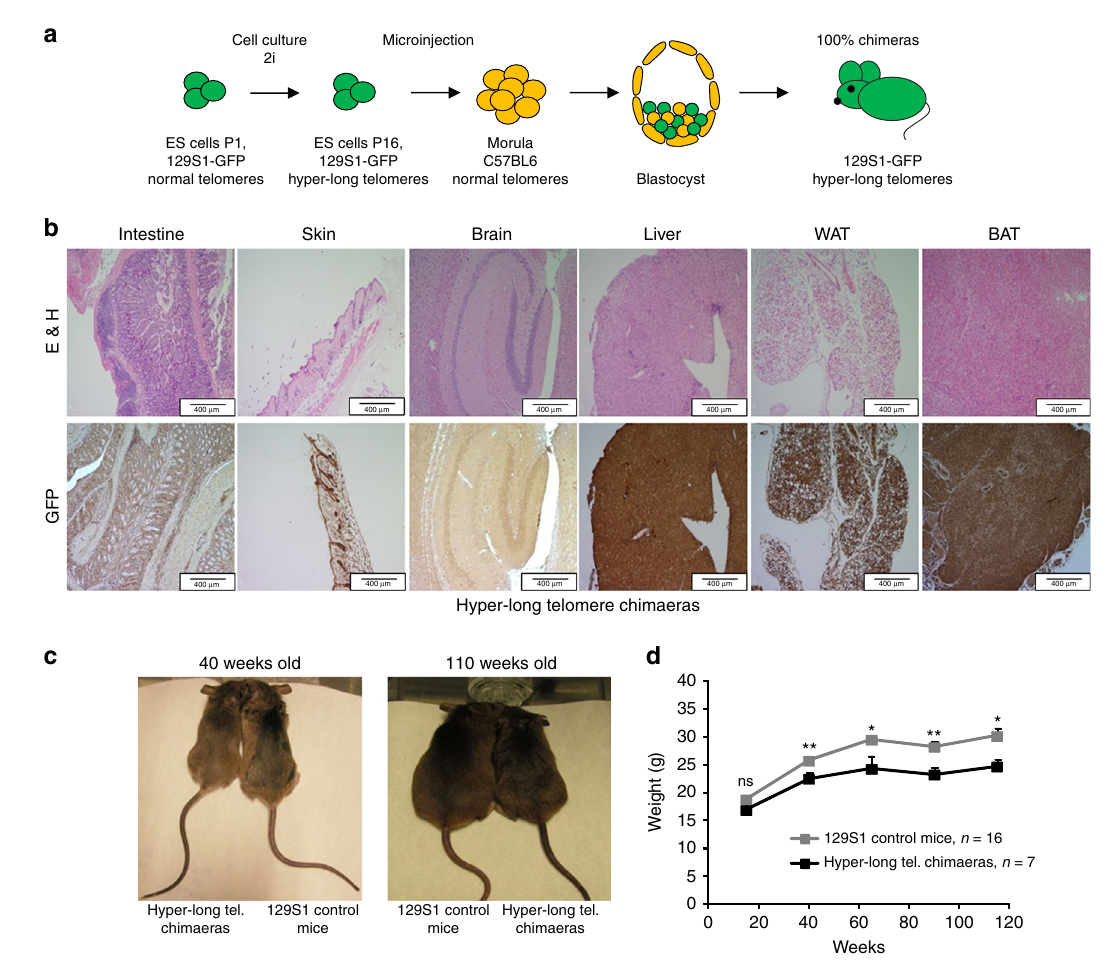
Fig. 1 Hyper-long telomere mice are leaner than normal mice. a Scheme showing generation of mice with hyper-long telomeres. eGFP ES cells are cultured in 2i medium until passage 16 and they are microinjected into morulae to obtain 100% contributing chimaeras. b Representative images showing 100% eGFP ES cell contribution in different organs and tissues. c , d Longitudinal follow up of weight in the indicated cohorts. Hyper-long telomere mice show a signi fi cant reduction in body weight from 40 weeks onwards ( c ) and this body size reduction is maintained until the last timepoint measured ( c , d ). Error bars represent standard error. t -test was used for statistical analysis. The number of mice is indicated in each case. * p < 0.05. ** p < 0.01. Source data are provided as a Source Data fi